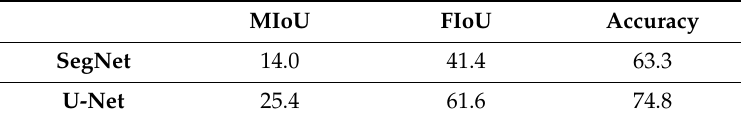
Figure 8. Classification result. ( a ) is image, ( b ) is ground truth, ( c ) is SegNet result and ( d ) is U-Net result. Table 4. Result of MIoU, FIoU, and accuracy (unit Table 4. Result of MIoU, FIoU, and accuracy (unit %).